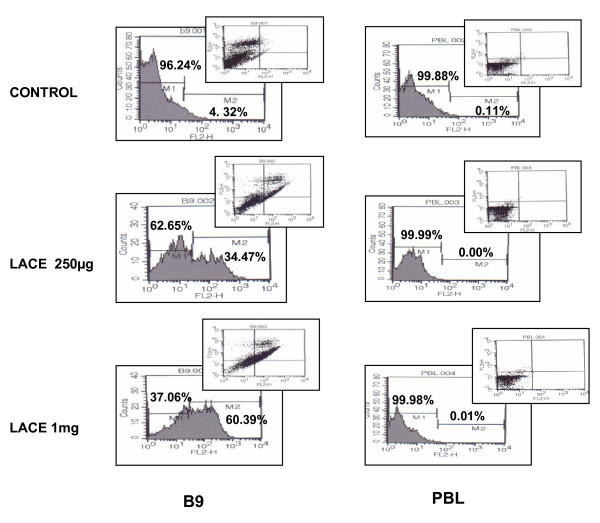
Apoptosis induced by LACE. B9 cell line was untreated or treated with 250 μg/ml or 1 mg/ml of LACE for 96 h. Cells were double-stained with annexin V and 7AAD and analyzed by flow cytometry. PBLs were also analyzed and LACE extract did not produce apoptosis. All experiments were performed at least three times and gave similar results.